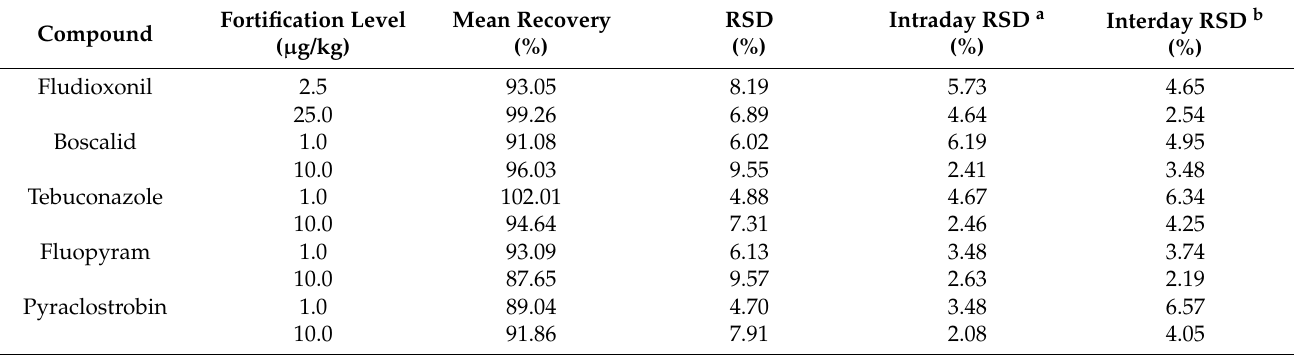
Table 4. Recovery (n = 5), repeatability and intra- and interday precision data for the studied pesticides in fortified persimmon